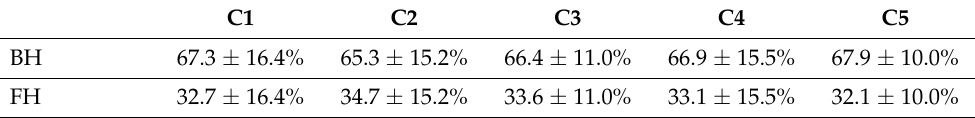
Table 3. Distribution of backhand and forehand executions for each class (mean ±